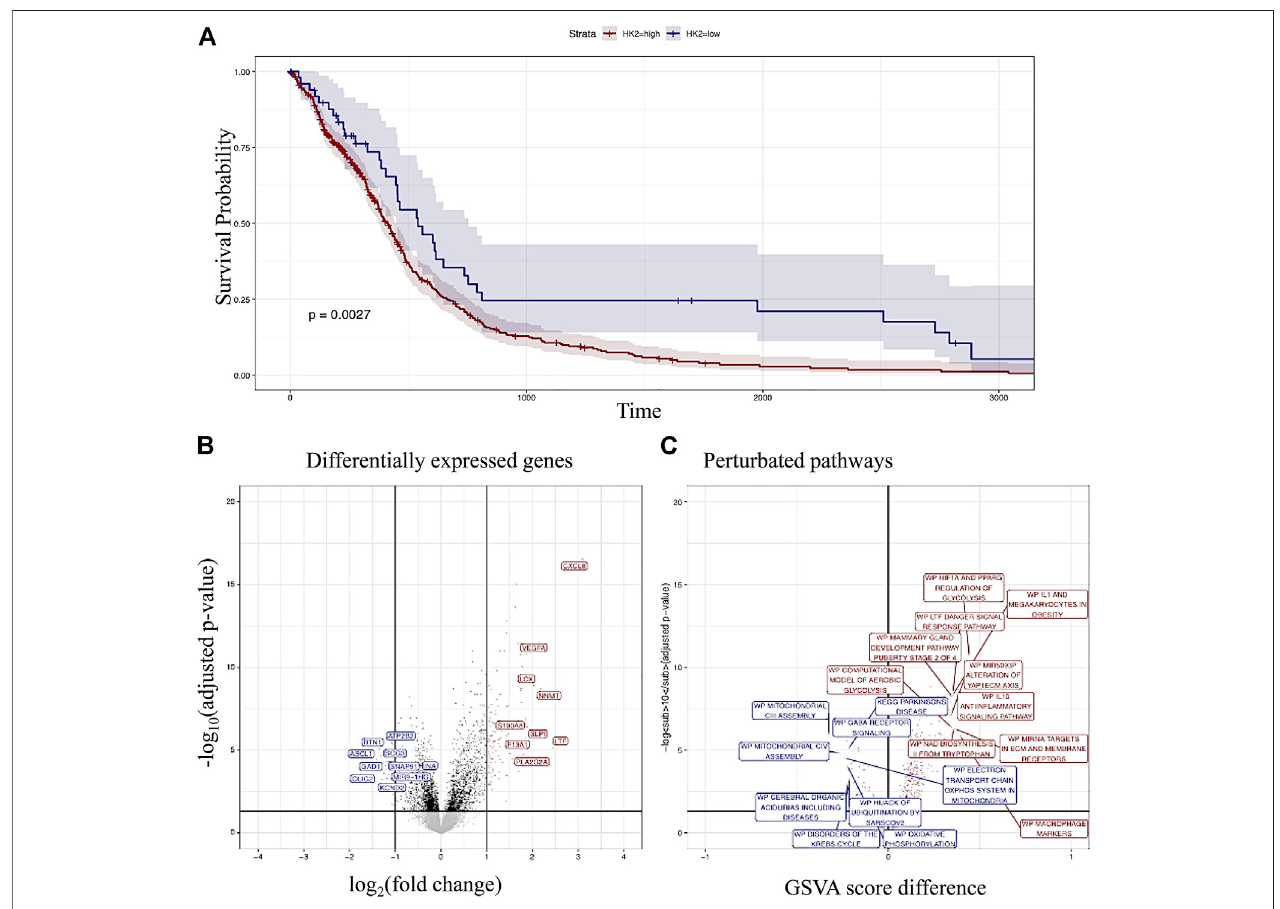
FIGURE 1 | High expressors of HK-II display poor prognosis according to the glioma cohort analysis. Kaplan – Meyer analysis of HK-II high versus low expressors (A) . Differentially expressed genes in HK-II high versus low expressors (B) . Differentially regulated pathways in HK_II high versus low expressors (C) .